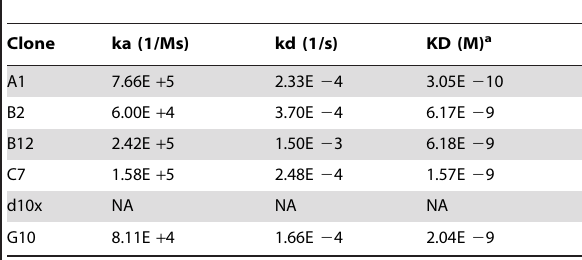
Table 2. Binding kinetics for